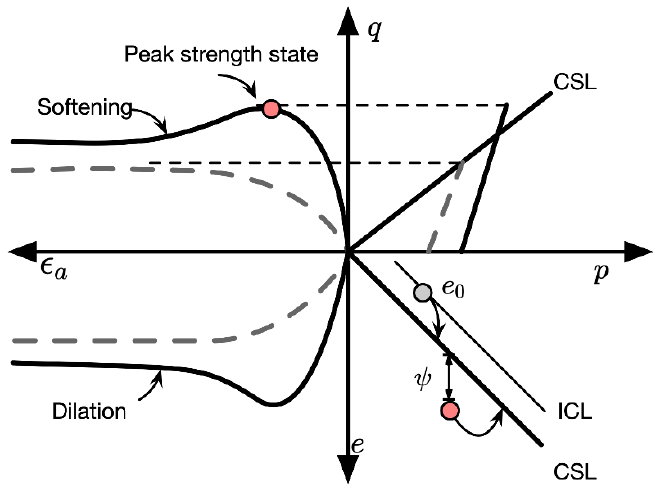
Figure 1. The typical drained triaxial response of the normally consolidated and over-consolidated clay samples.